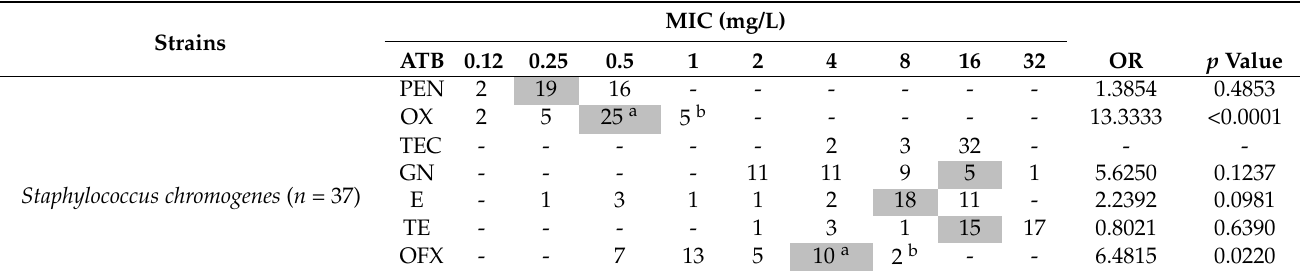
Table 1. MIC determination of S. chromogenes using agar dilution method.